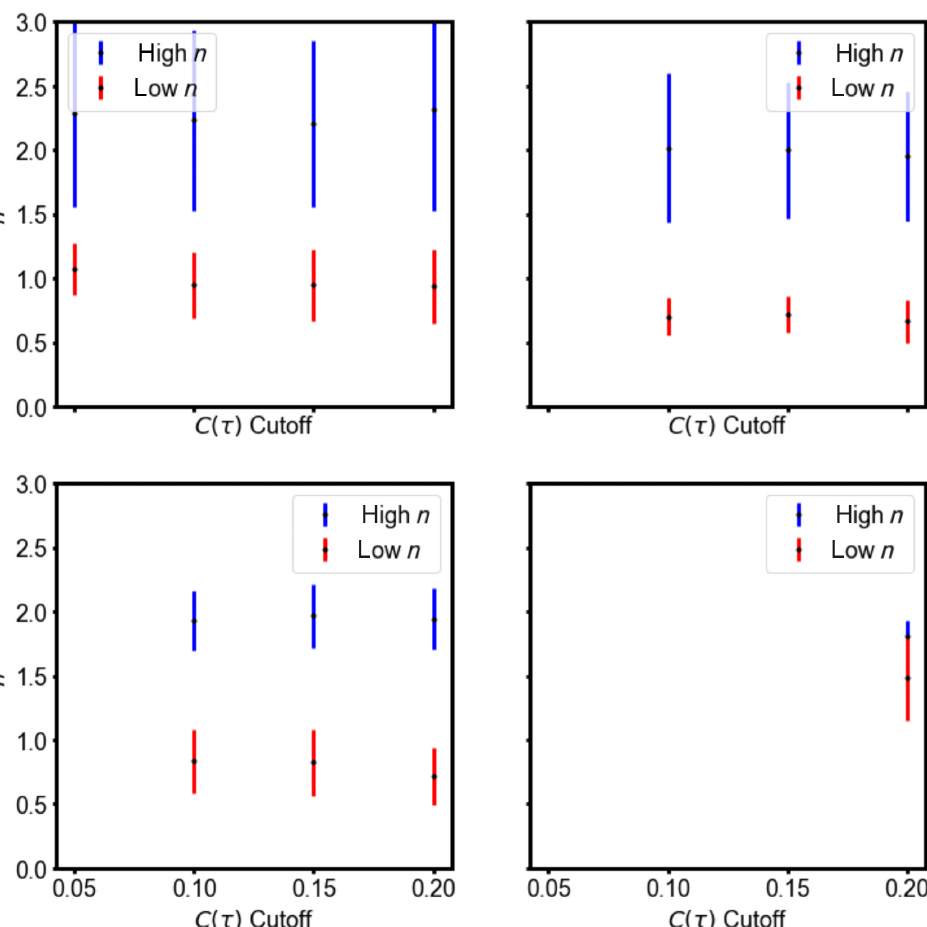
FIG. 21. Stability of stretching factors. Mean and standard error of the two stretching factors (high n and low n ) of Eq. (H2) as a function of the cutoff value of the coherence for the four NV centers in Fig. 20. For two NV centers, C (τ) does not dip below 0.1 during the measurement period and for one NV center, C (τ) does not dip below 0.2 during the mea- surement period. However, extracted exponents remain stable for all NV centers regardless of the exact C (τ) cutoff value.